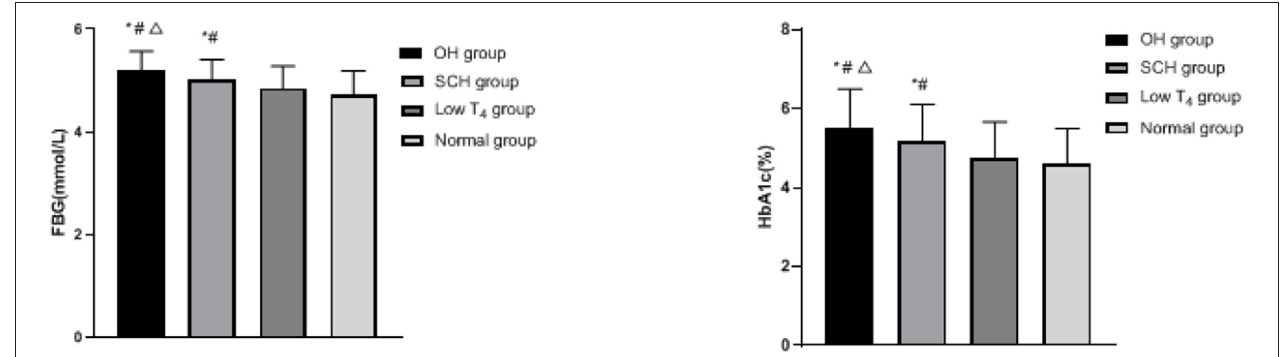
FIGURE 1 | Comparison of blood glucose levels in each group; compared with the normal group, * p < 0.05; compared with the low T 4 group, # p < 0.05; compared with the SCH group, 1 p < 0.05.